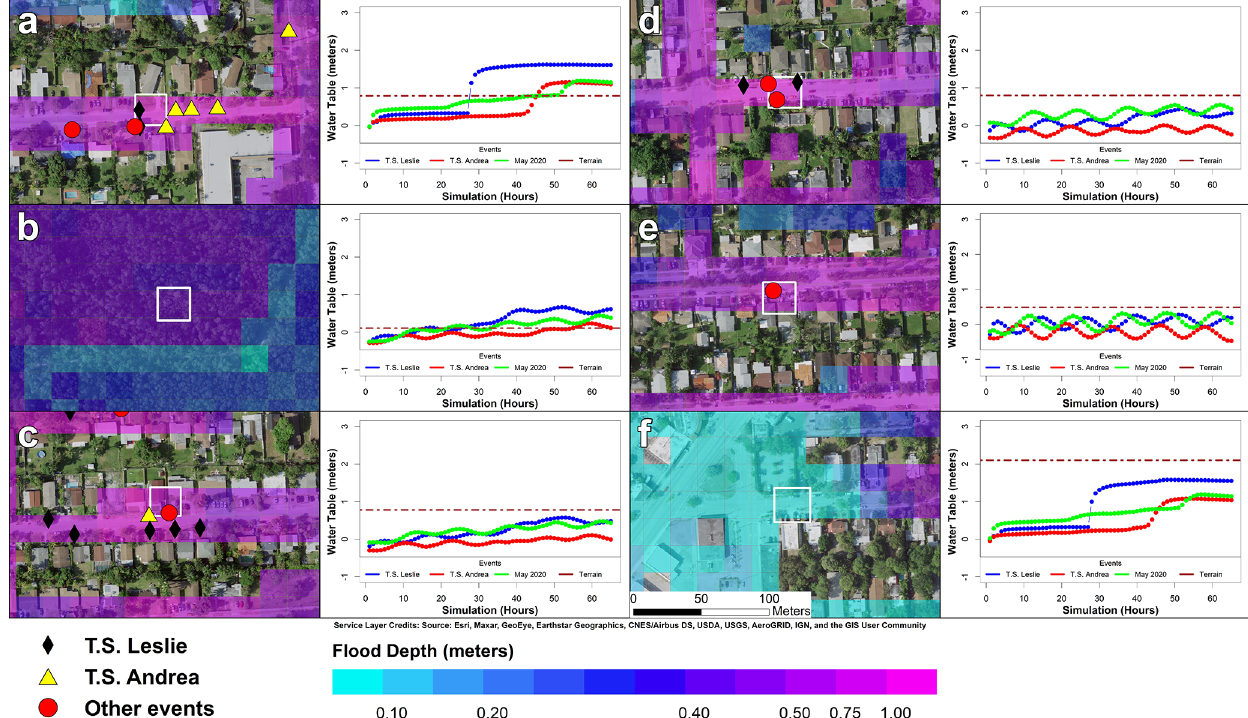
Figure 12. Six sample locations (Fig. 10) are selected to observe the maximum flood depths for Tropical Storm Leslie (a–c) . The markers display repetitive loss properties that have been affected by Tropical Storm Leslie (black), Tropical Storm Andrea (yellow) and other storm events (red). The water table time series (a–c) display the behavior of the groundwater heads during Tropical Storm Leslie (blue line), Tropical Storm Andrea (red line) and the 25 May 2020 event (green line) at a specific location (white). Results demonstrate that the simulated water table (d–f) exceeded the surface elevation (brown line) at two locations leading to groundwater-induced flooding (a, b) , while the rest are driven by pluvial flooding (c–f) . Table 3. Comparison between simulated maximum water flood depths and VGI imagery obtained during and after Tropical Storm Andrea. No. Latitude Longitude Image category Interpreted Max Difference depth (m) simulated (m) depth (m) 1 − 80 . 165579 25.910225 During storm 0.20 0.67 − 0 . 47 2 − 80 . 157365 25.908227 During storm 0.55 0.54 0.01 3 − 80 . 170807 25.900715 After storm 0.25 0.23